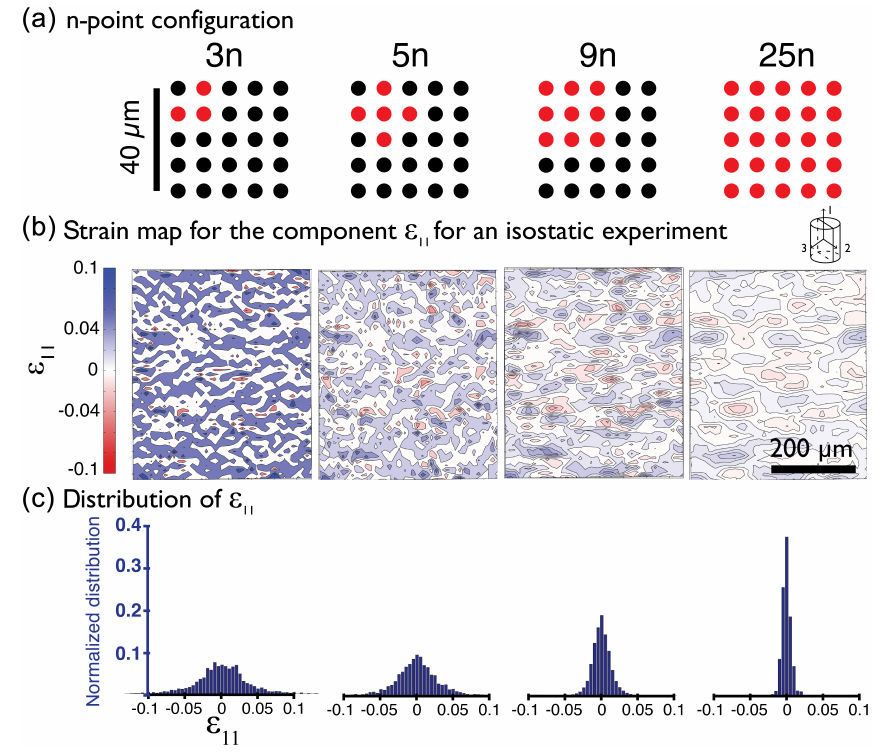
Figure 6. (a) The n -point configurations for n = 3, 5, 9, and 25. (b) Corresponding strain maps and strain distributions for strain along axis 1 in the sample reference (see insert for reference frame) for a Carrara marble cylinder isostatically annealed at T = 700 ◦ C and P c = 300MPa for 3h. (c) Corresponding strain distribution for each strain map; it can be observed that the mean is always 0 but the spread of the distribution becomes smaller with increasing n . Modified after Quintanilla-Terminel and Evans